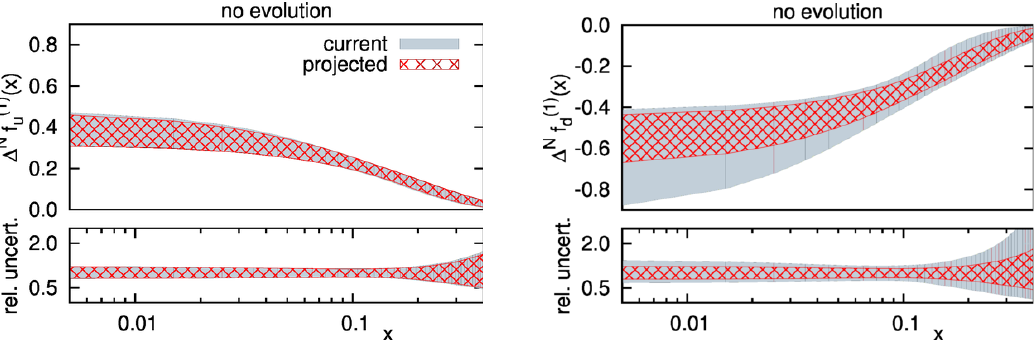
Figure 10 . First moment of the extracted Sivers distributions for u = u v + (cid:22) u (left panel) and d = d v + (cid:22) d (right panel). The shaded bands correspond to our estimate of 2 (cid:27) C.L. error. The light-blue bands show the uncertainties corresponding to our reference (cid:12)t (see table 2). The red (meshed) bands correspond to the uncertainties estimated by using the same model, with the projected experimetal errors of the future COMPASS run on deuteron target